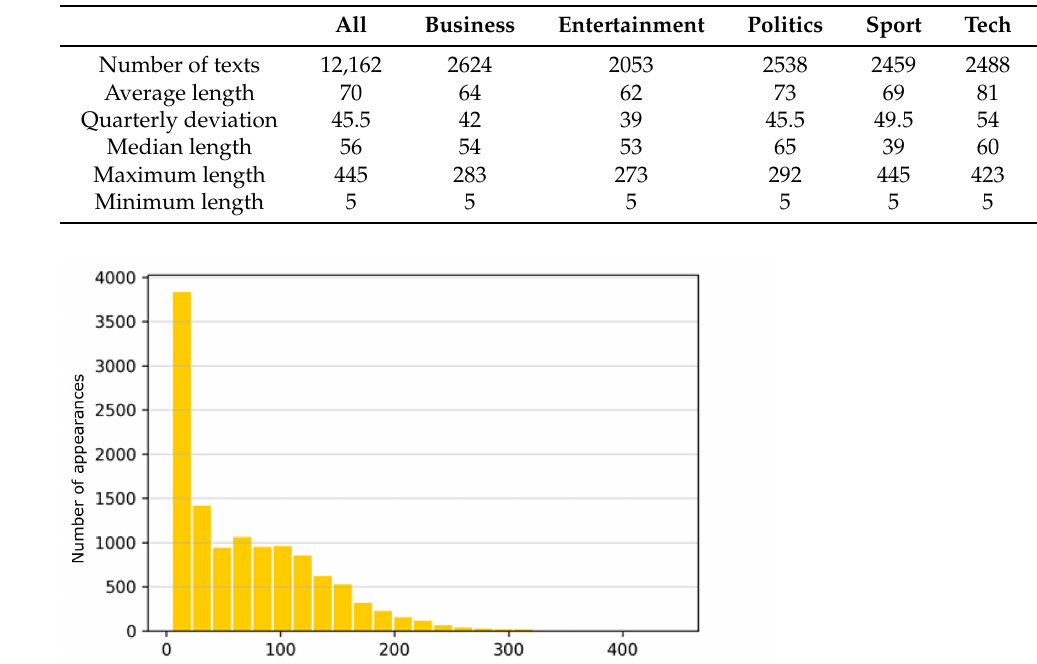
Table 1. Summary statistics of the data in all of the studied texts by category.